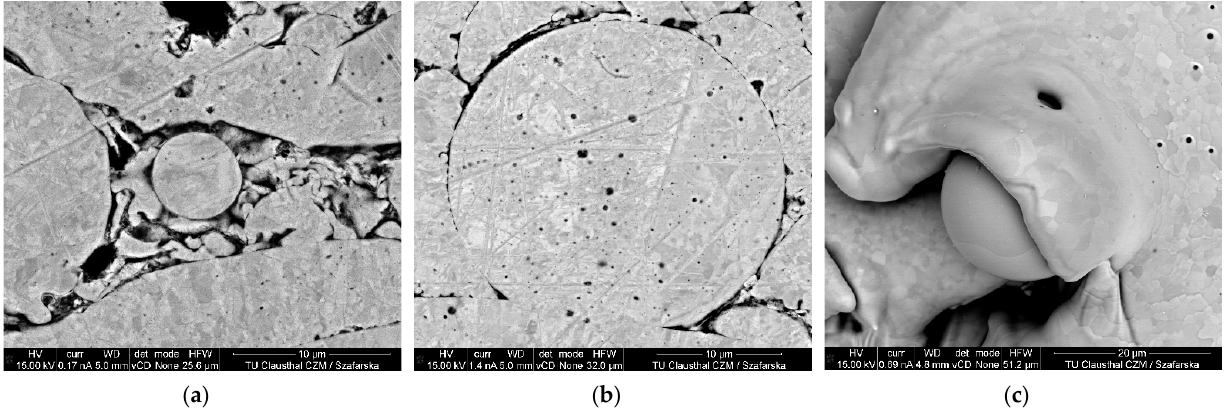
Figure 9. SEM micrographs of undeformed and trapped copper particles in wire arc copper coatings formed in an XHV-adequate environment: ( a ) particle entrapment in the vicinity of pores, ( b ) partially bonded copper particle and ( c ) by splat partially covered particle on the coating surface.